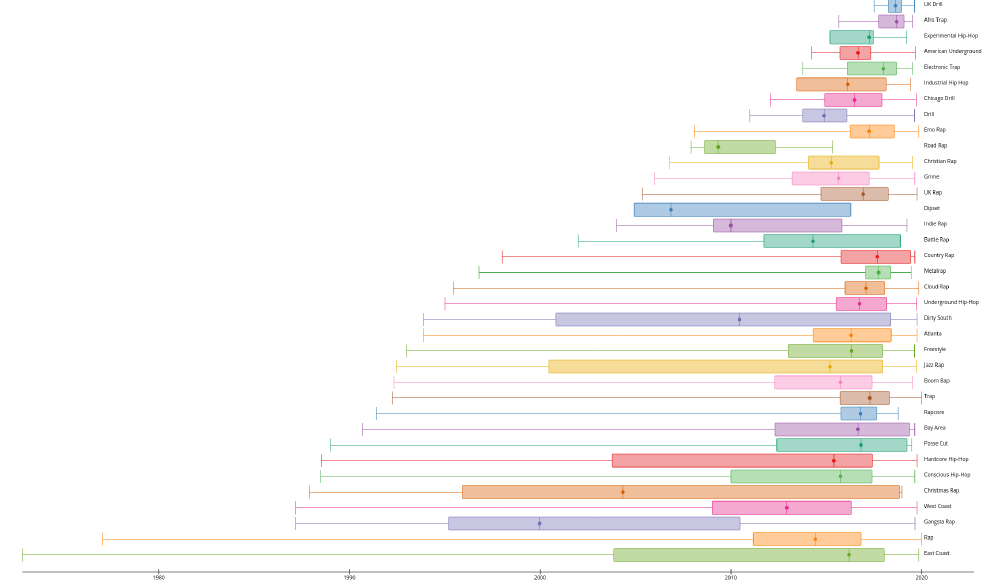
Figure 9. A timeline visualizing all rap genres associated in the Genius Expertise dataset. Each genre is shown as a